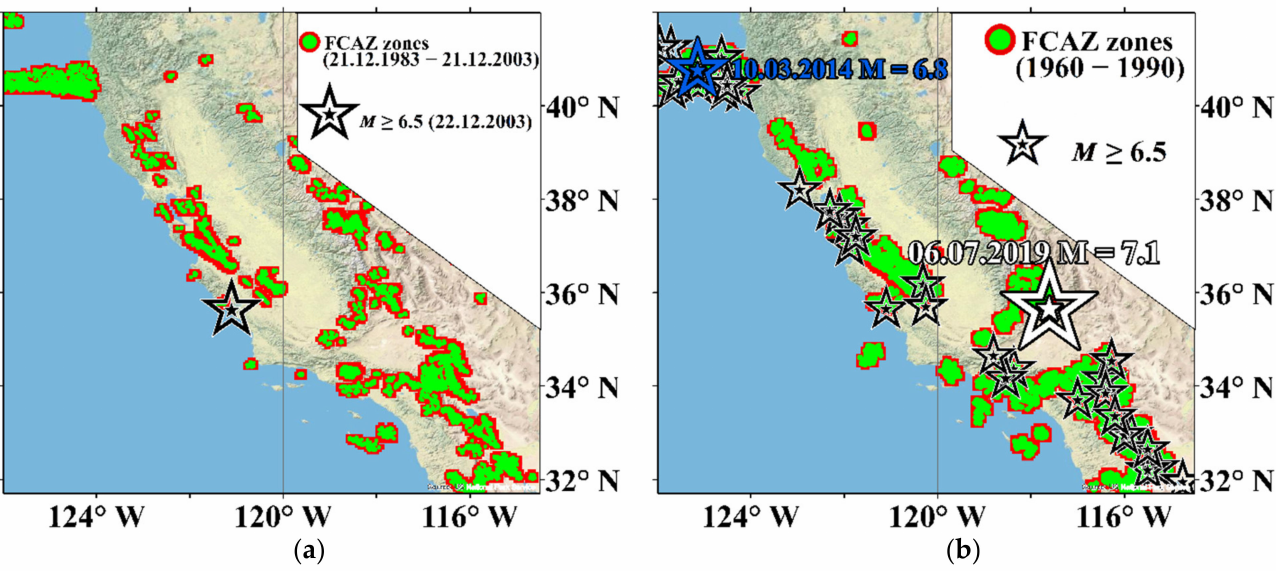
Figure 11. California: ( a ) computational individual seismic history experiment for the earthquake dated 22 December 2003; ( b ) computational complete seismic history experiment (1960–1990) and the epicenters of earthquakes with M ≥